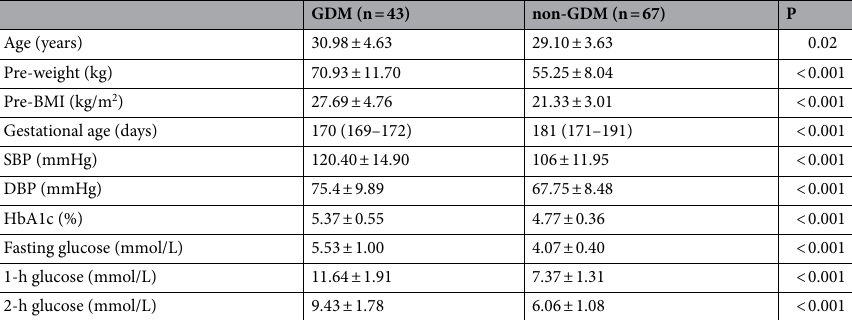
Amino acids (µmol/L) GDM (n = 43) non-GDM (n = 67)